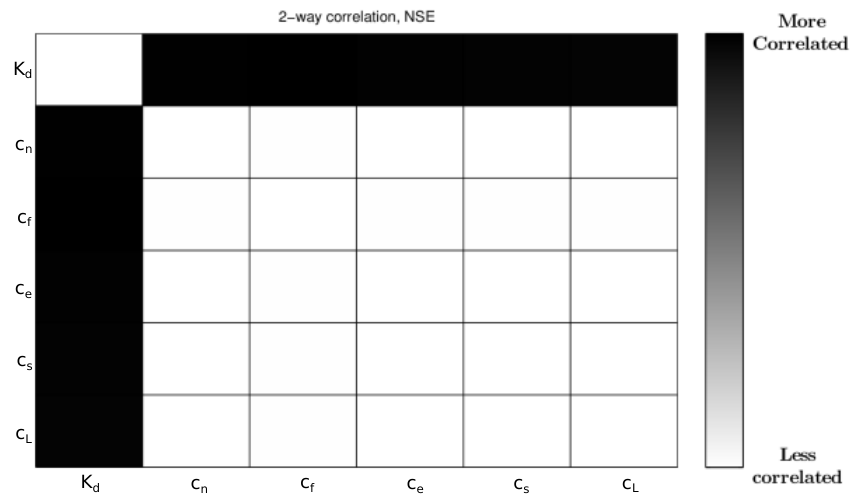
Figure 5. Two-way correlation between selected parameters of the Canadian Small Lake Model. This indicates how much the value of a given parameter is dependent on the value of another one to produce good simulations. The Nash–Sutcliffe performance was used to evaluate the model. McKay-2 (McKay et al., 1999) was used to evaluate the correlation.